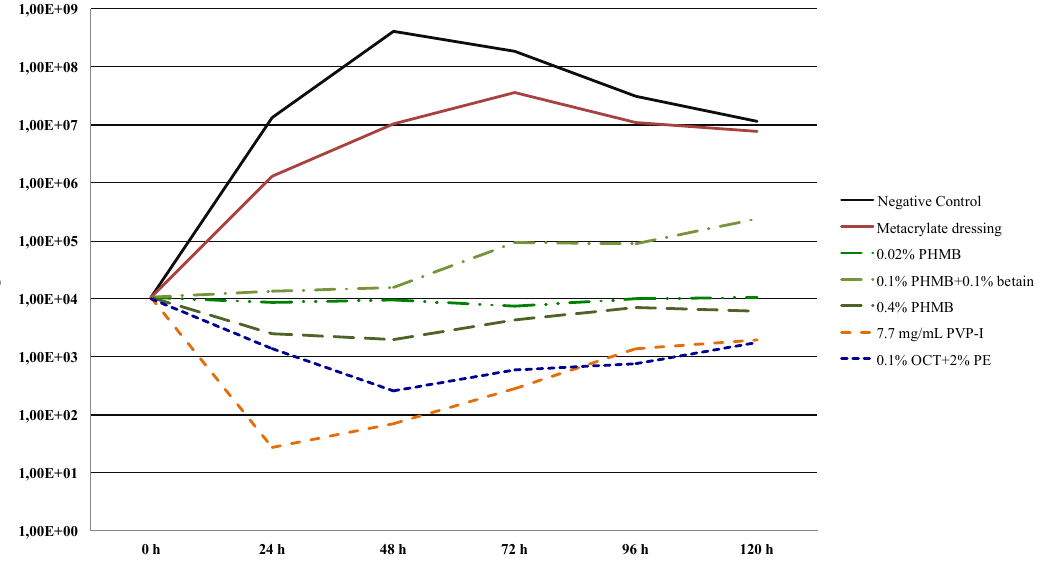
Figure 1. Kill-time study and bacterial growth kinetics of S. aureus (ATCC 33591) in presence and absence of a methacrylate dressing with and without single loading of antiseptics over five days application. Bacterial counts expressed as absolute numbers per gram of tissue. Data represent the means of four independent experiments each after standard contamination with 1.0 × 10 7 cfu S. aureus per gram tissue. Results are depicted using absolute